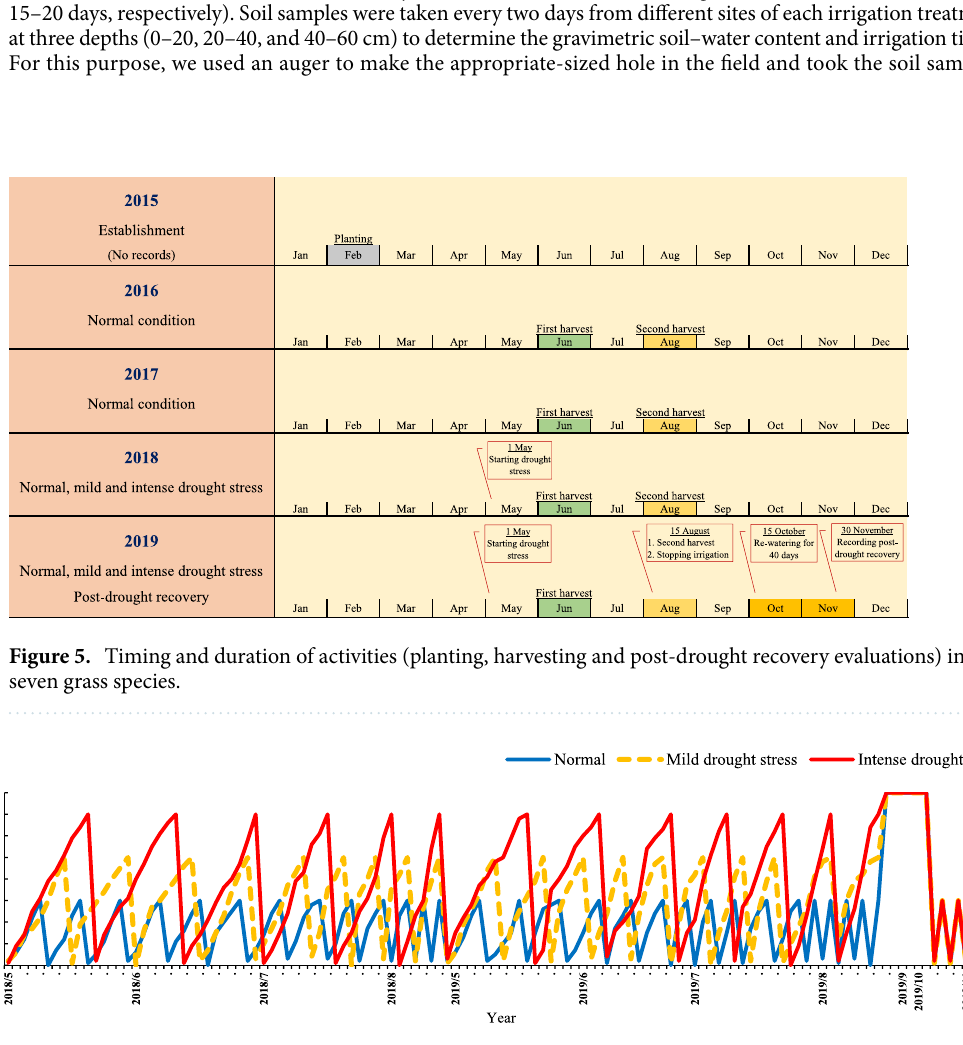
Figure 6. Schematic scheme of percentage of soil water depletion for three different moisture environments (normal, mild and intense drought stress) used in this study. Blue lines denote to the normal environment and orange lines denote to the mild drought stress and red lines denote to the intense drought stress during 2018– 2019 (from the first of May to the middle of August). In this study, twenty-eight genotypes (from seven species of cool-season grass) were evaluated for plant functional traits and survival in the field during 2016–2019, under normal and drought stress conditions. In the fourth year (on August 2019), irrigation was withheld in